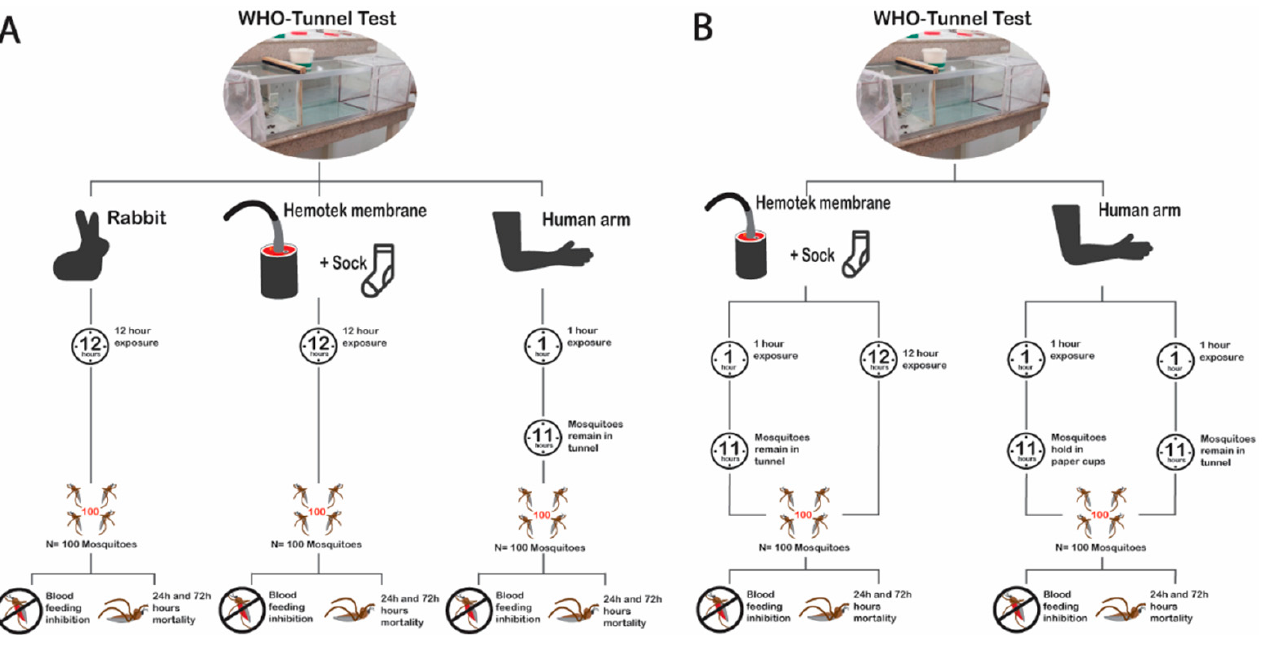
Figure 2. Flow chart of experimental procedure, experiment 1 ( A —impact of baits) and experiment 2, ( B —effects of exposure time 12-h vs. 1-h) on WHO tunnel test outcomes.